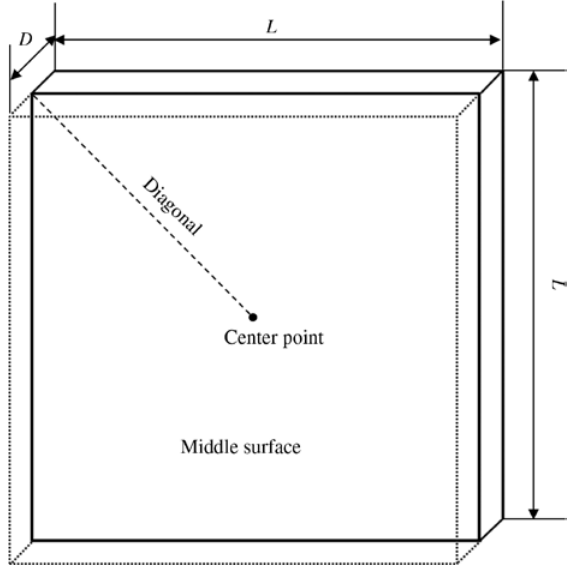
Figure 6: Degree of cure profile of the center point of the